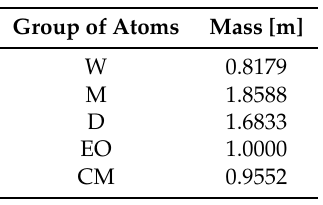
Figure 4. The SAFT CG model. ( a ) SAFT CG model for water (one-bead–one-water and one-bead–two-waters models) and C 10 E 4 surfactant. Transparent spheres indicate the CG beads and the atoms that they represent. Alkyl groups are in turquoise, ethoxy groups in grey and red beads represent the head groups. From Ref. [67]; ( b ) Experimental phase diagram for C 10 E 4 surfactant and representative snapshots from simulation based on the SAFT CG model. From Ref. [67]; ( c ) Experimental phase diagram [110] for water–Silwet-L77 (superspreading surfactant) and representative snapshots from computer simulations based on the SAFT CG model. Colours indicate different parts (hydrophobic or hydrophilic) of the surfactant and water as indicated. Reproduced from Ref. [19] with permission from The Royal Society of Chemistry; ( d ) Surface tension versus surface excess concentration in the case of C 10 E 4 surfactant. Open symbols correspond to experimental data [111], while filled circles are results obtained by simulation based on the SAFT CG model. From Ref. [67]. Table 2. Mass in units m for different effective beads representing groups of atoms. See main text for